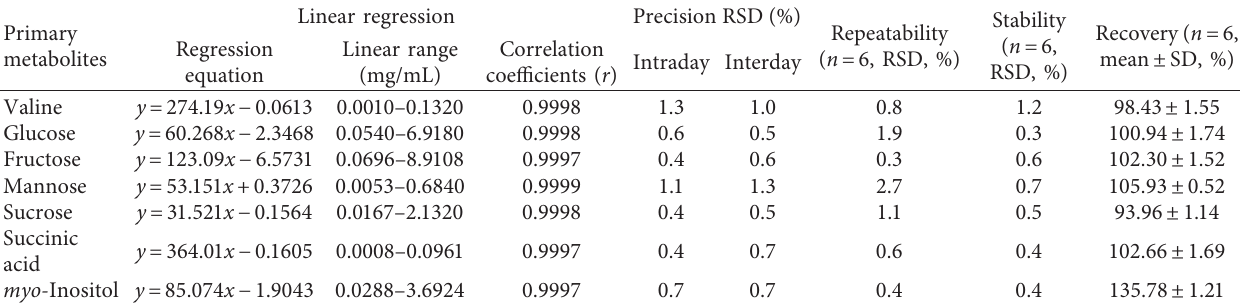
Table 3: Summary results of linear regression, LODs, LOQs, precision, repeatability, stability, and recovery for the primary metabolites in